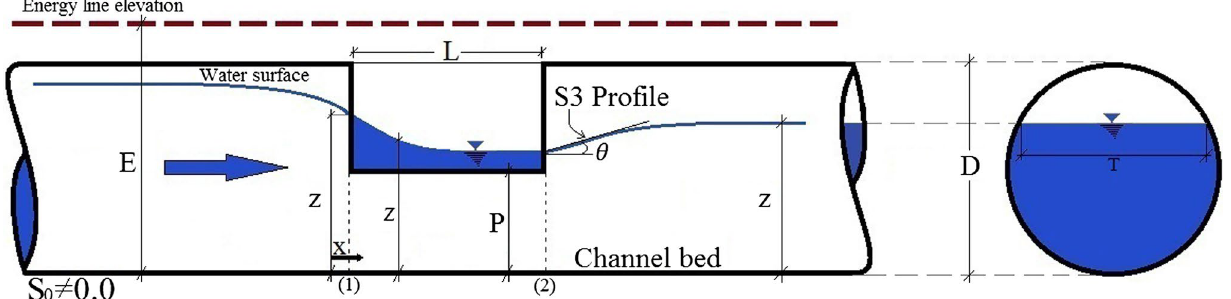
Fig. 2 Schematic layout of circular channel with side weir used by Uyumaz and